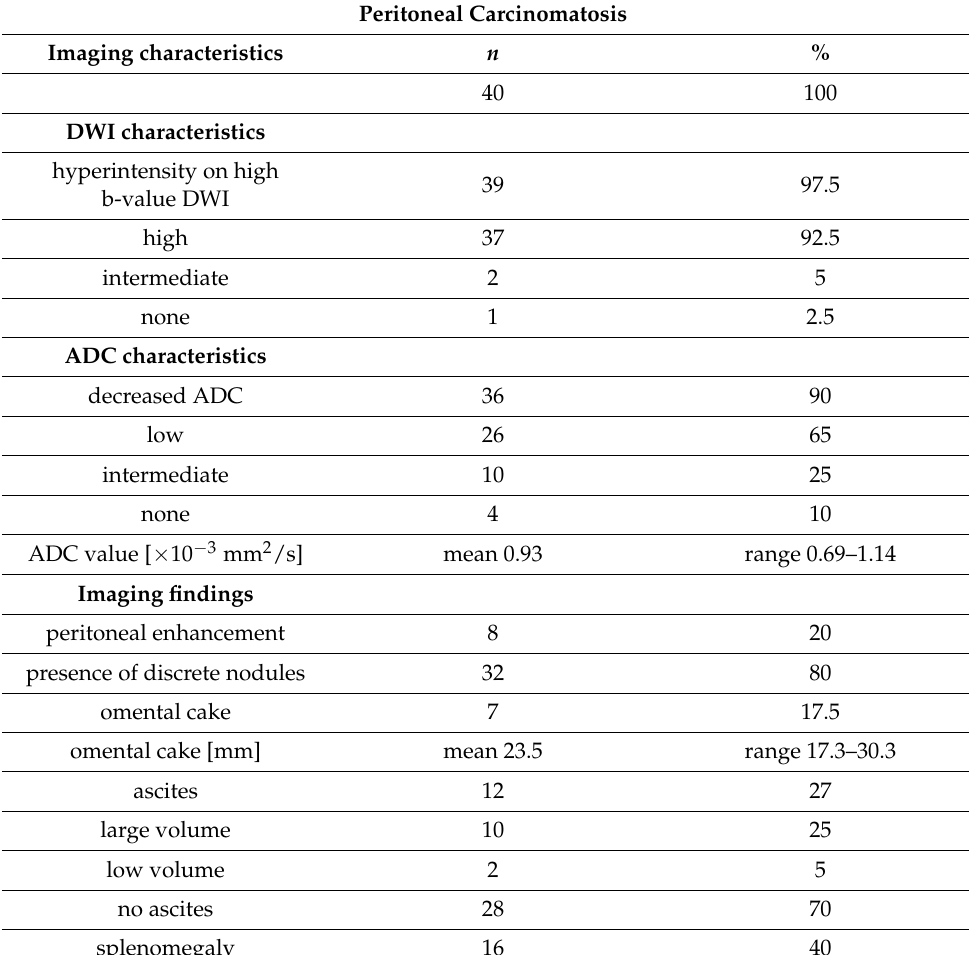
Table 3. MRI-features and associated findings in peritoneal carcinomatosis.